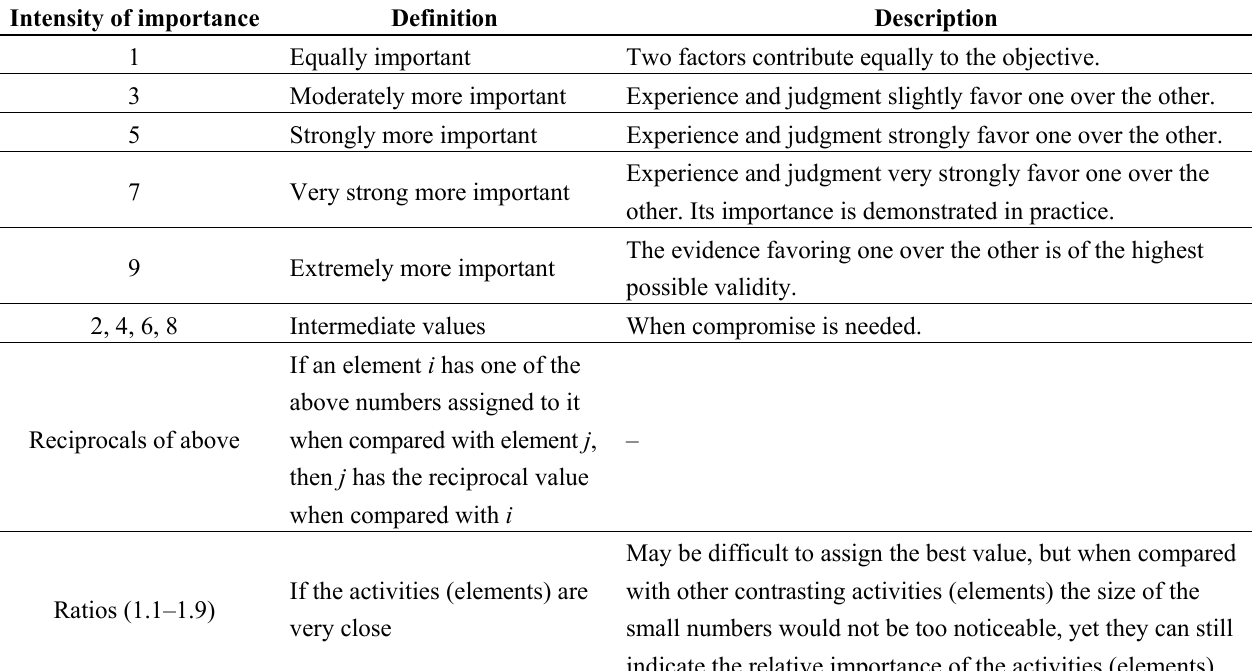
Table 1. Nine-point intensity of importance scale, modified from Schoenherr [31], Copyright 2008